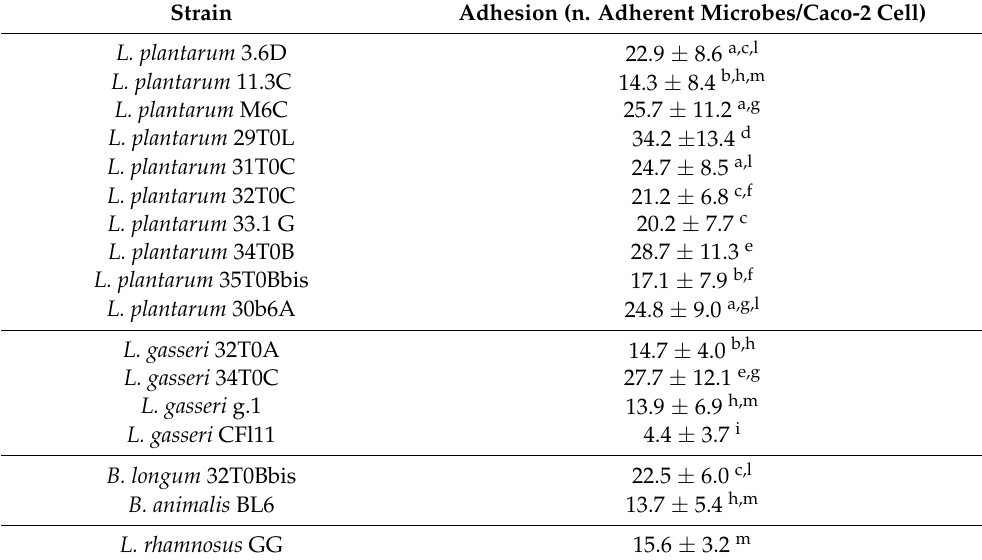
Table 2. Adhesion of breast milk lactobacilli/bifidobacteria strains on differentiated Caco-2 cells. Data are expressed as number of adherent microbial cells/Caco-2 cell and shown as average ± SD. Samples equipped with different letters are significantly different ( p <